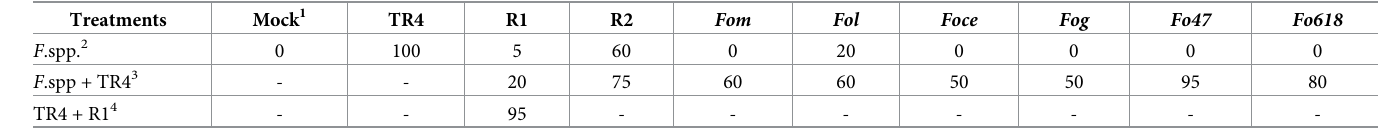
Table 2. Disease Indexes of banana plants treated with different pathogenic and non-pathogenic strains of Fusarium spp . Treatments